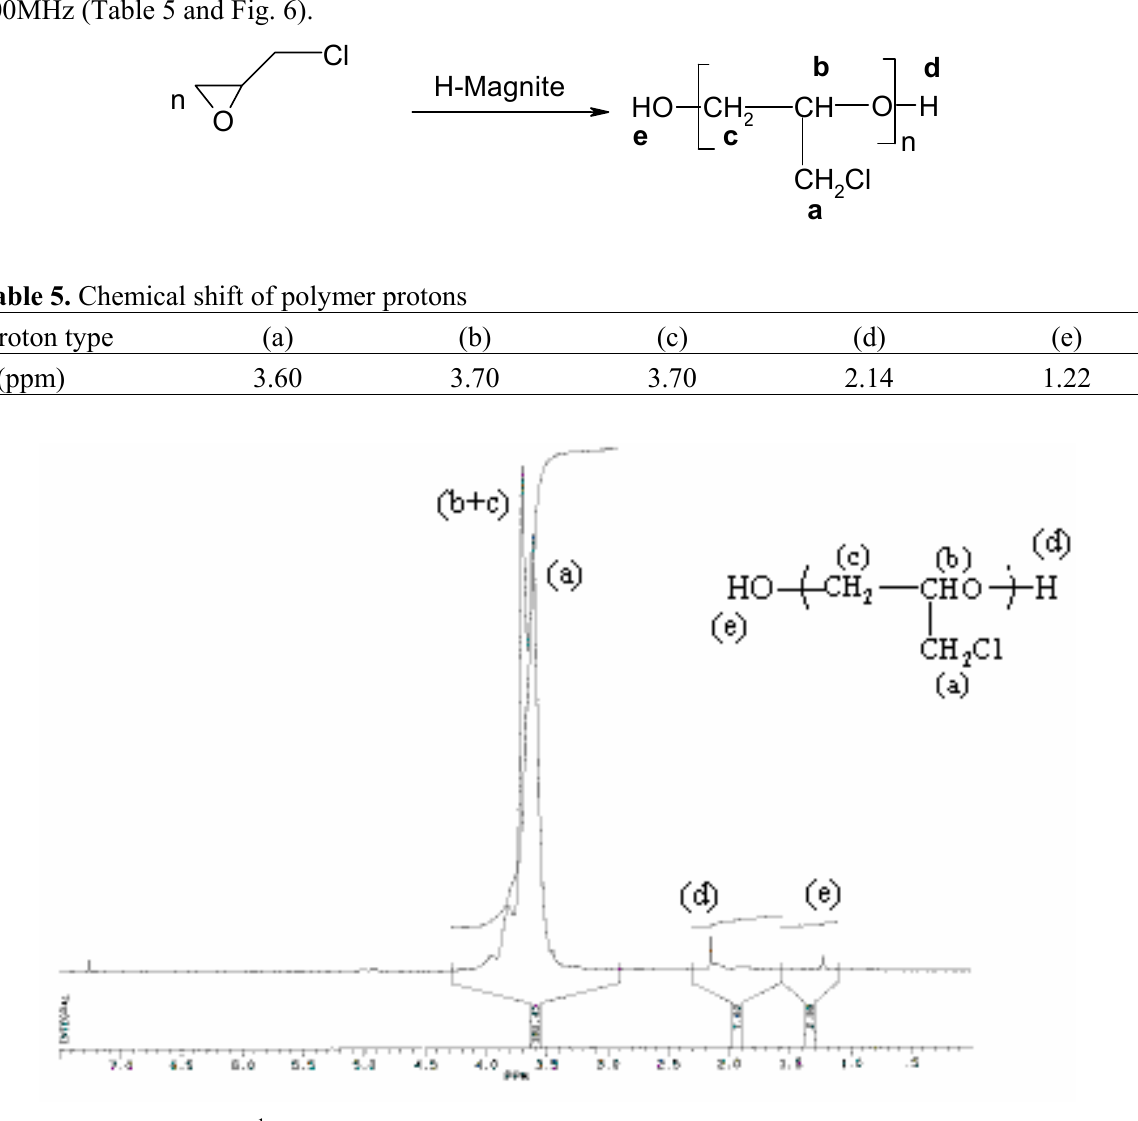
Figure 6 . 1 H NMR (200 MHz) spectrum of polyepichlorhydrin in CDCl